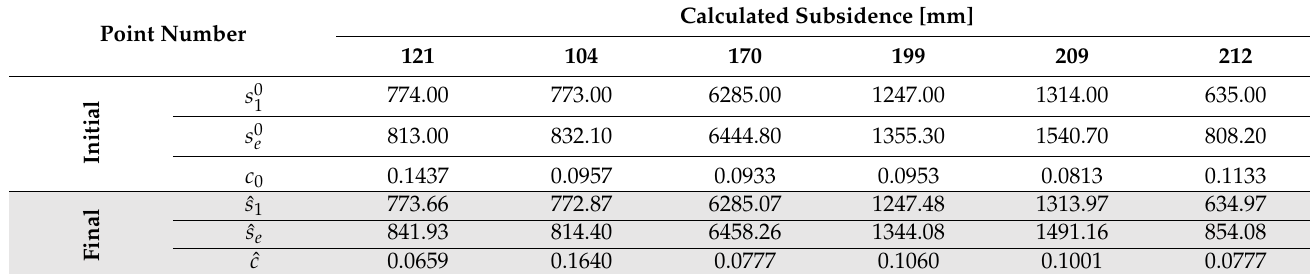
Table 2. Initial (calculated using 3- or 4-point method [30]) and final parameters using the Gauss– Markov equalization algorithm.